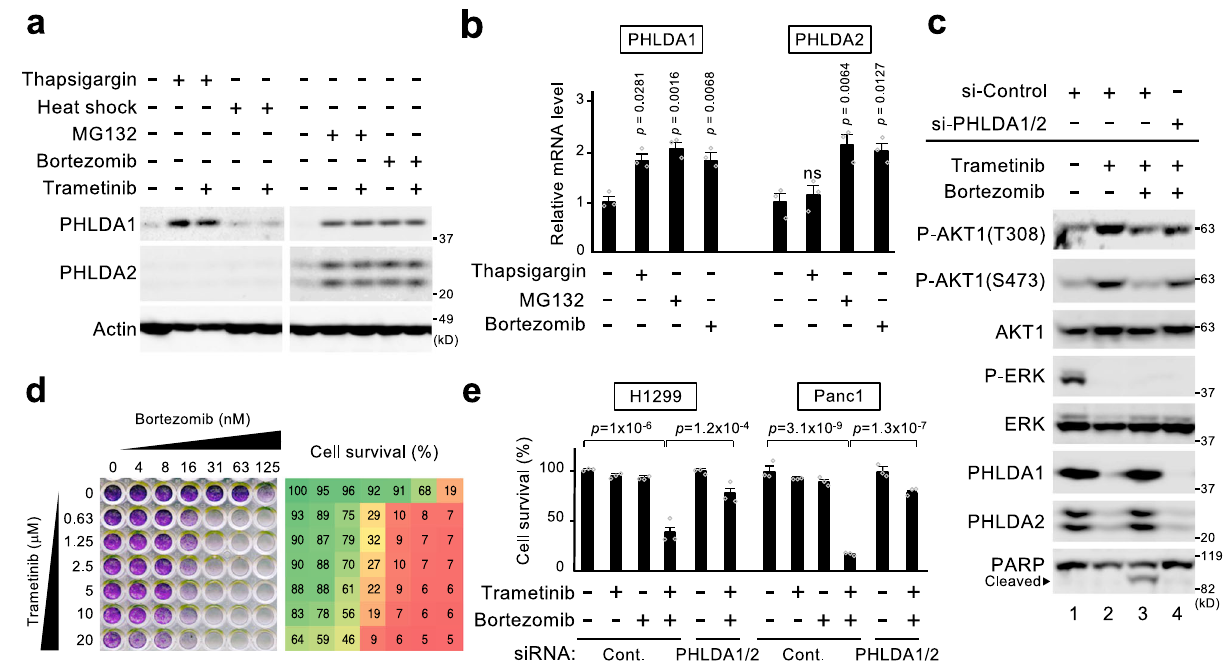
Fig. 10 Bortezomib potentiates the ef fi cacy of ERK-targeted therapies by upregulating PHLDA1/2 expression. a , b HEK293 cells were treated with thapsigargin (6 h), heat-shock (1 h), MG132 (6 h), or bortezomib (6 h) in the presence or absence of trametinib as indicated. PHLDA1/2 protein and mRNA expression levels were analyzed by immunoblotting ( a ) and qRT-PCR ( b ), respectively. c Retention of PHLDA1/2 expression by bortezomib prevents trametinib-induced AKT activation. H1299 cells that were transfected with siRNAs targeting PHLDA1/2 or control siRNA were treated with trametinib alone or in combination with bortezomib for 9 h. Expression levels of PHLDA1/2, the phosphorylation states of AKT and ERK, and cleaved PARP were monitored by immunoblotting. d , e MEK and proteasome inhibitors synergistically inhibit cancer cell growth. d H1299 cells were treated with various concentrations of bortezomib or trametinib alone or in combination for 72 h. The cells were then stained with crystal violet (left), and their survival rates were analyzed by CCK8 assay (right). e H1299 or Panc1 cells were transfected with siRNAs targeting PHLDA1/2 or with control siRNA, were treated with trametinib (10 μ M) and/or bortezomib (10 nM) for 72 h, and their survival rates were then analyzed as in d . b , e Data are mean ± SEM from three independent experiments. P -values were assessed using one-way ANOVA followed by Tukey ’ s multiple comparisons test. Source data are provided as a Source Data fi